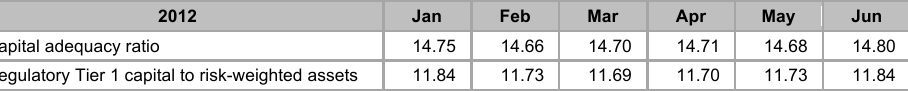
Capital-adequacy ratio and Regulatory Tier 1 capital to risk-weighted assets of the top four banks in South Africa for the first semester of 2012